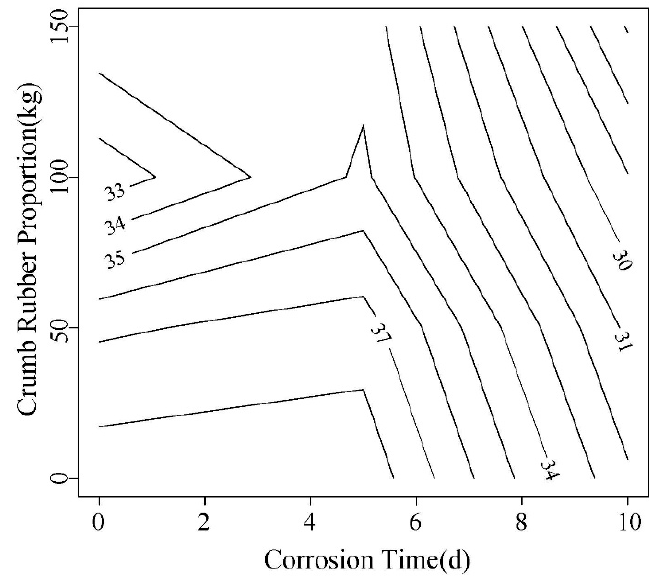
Figure 15. The corresponding load contour maps for 0.45 water-cement ratio 2.5 mm displacement.